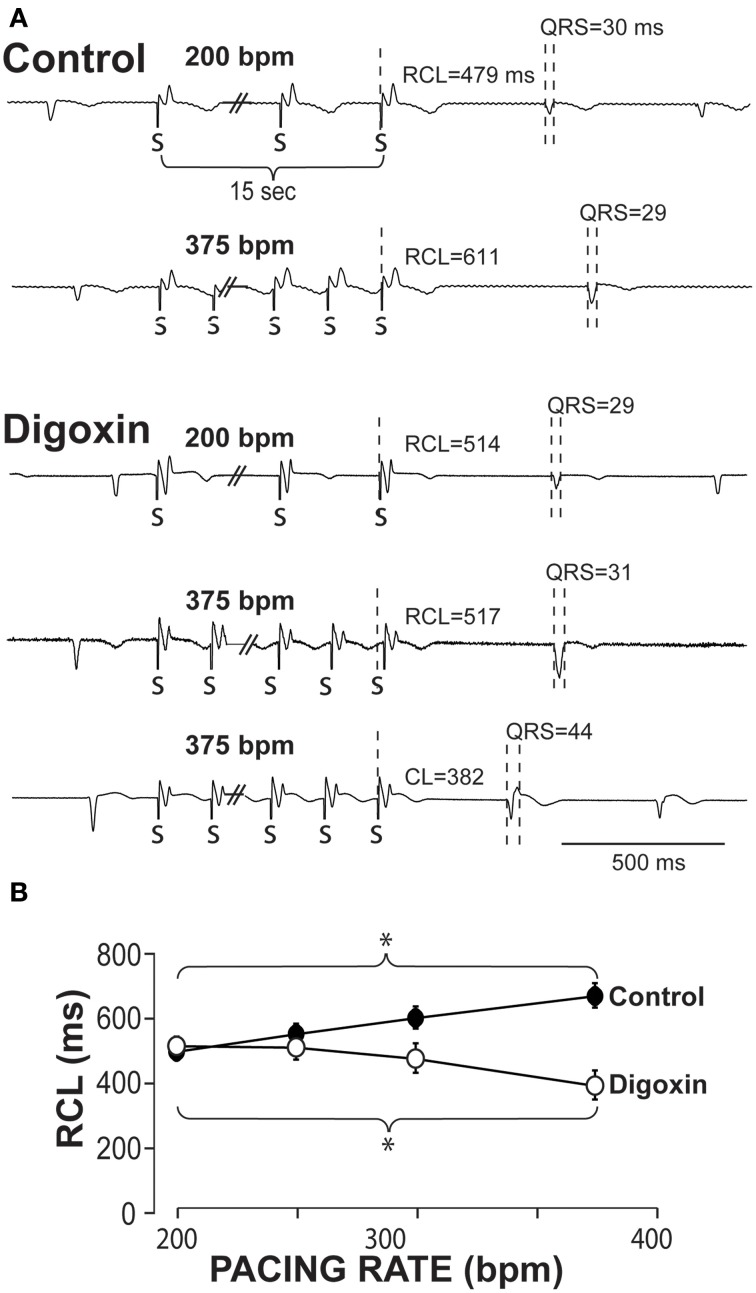
Recovery beats characteristics in response to slow and rapid pacing. (A) Representative volume-conducted electrocardiograms of control (top) and digoxin (bottom) at pacing rates of 200 and 375 bpm. Paced beats are marked by “S.” (B) Summary data of the recovery beat cycle length following different pacing rates. Control data had an increase in RCL (*p < 0.05, n = 11) as pacing rate was increased, while digoxin had a decrease in RCL (*p < 0.05, n = 12).